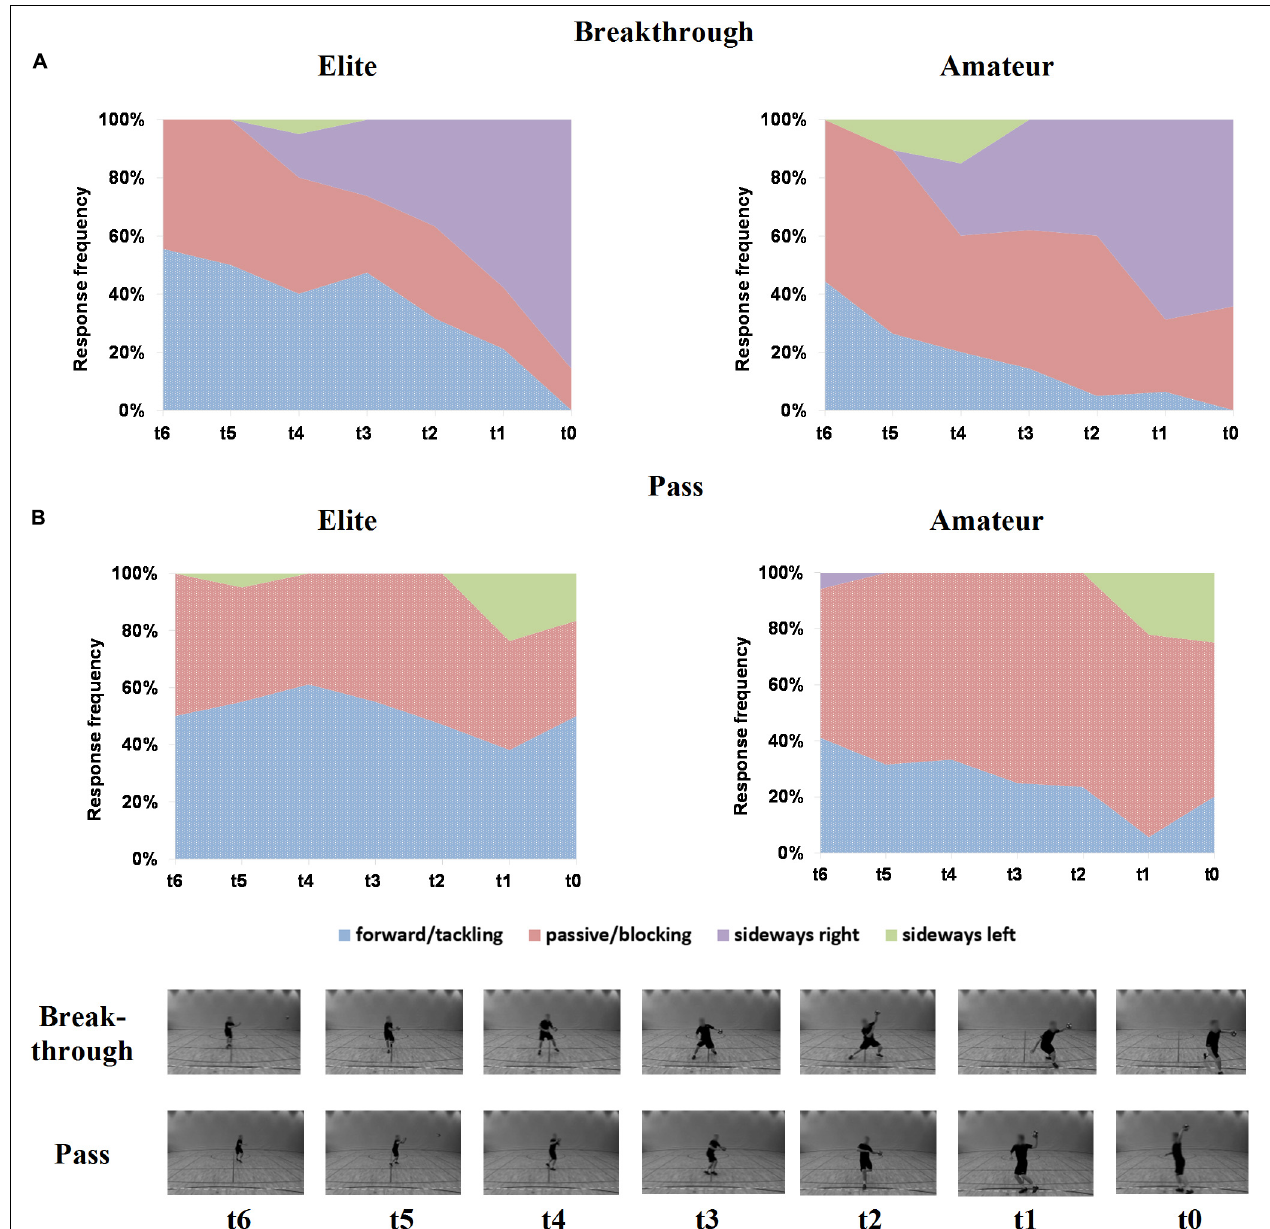
FIGURE 1 | Illustration of significant different frequency distributions of motor responses in left-handed Breakthrough (A) , and left-handed Pass (B) of elite (left) and amateur players (right). Stacked area graphs show occlusion points ( x -axis) and (relative) response frequency ( y -axis). Dotted areas denote significant frequency distribution differences between groups. Screenshots of each video (and its constituent occlusions) are shown at the